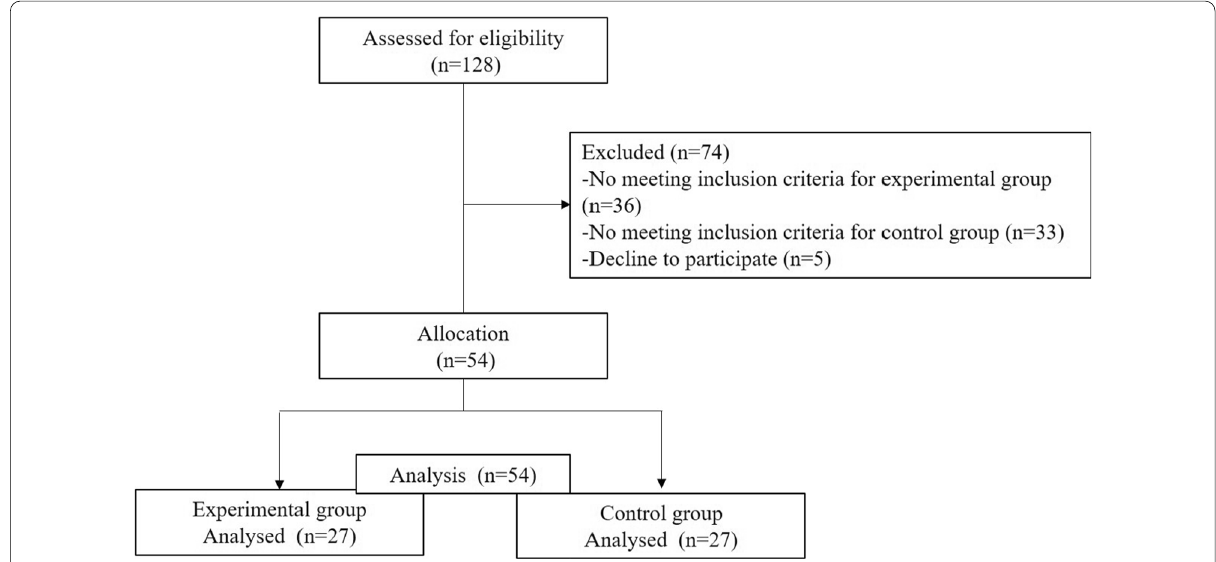
Fig. 1 Flow of participants throughout the